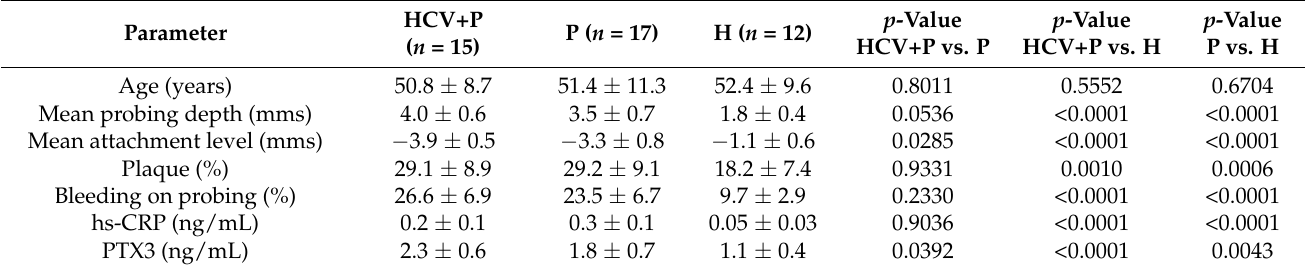
Table 2. Average ± standard deviation and statistical significance of analyzed parameters after